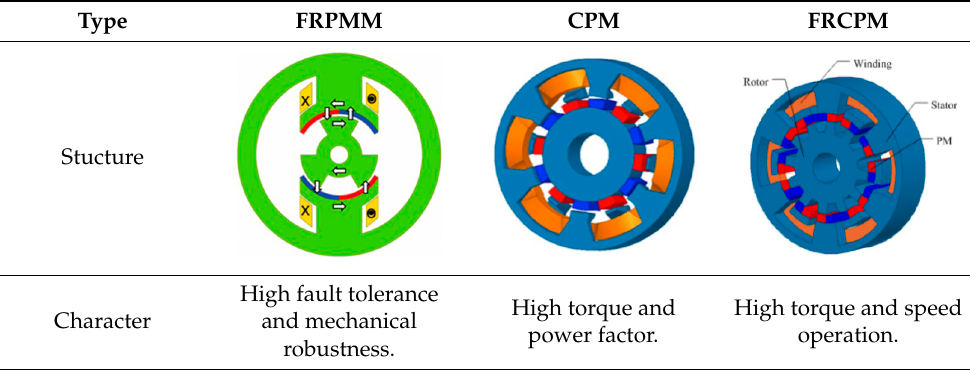
Table 1. Comparison of three kinds of motors.